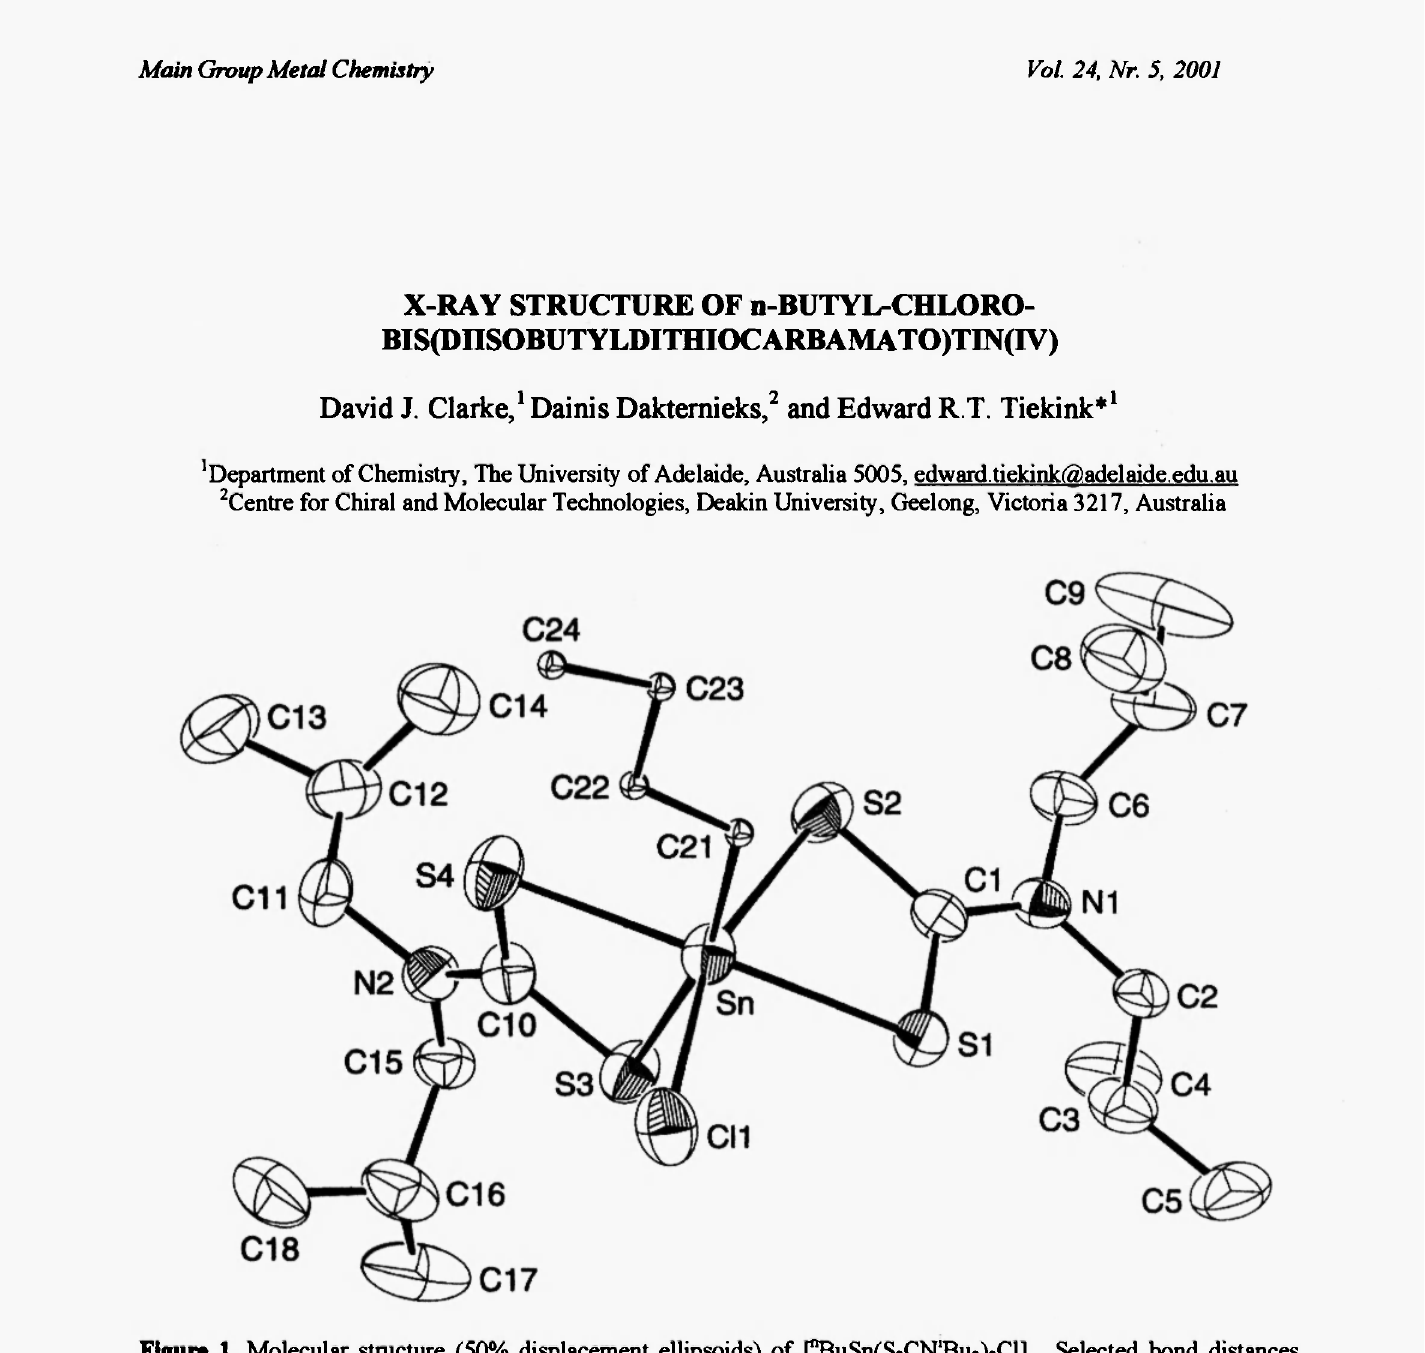
Figure 1. Molecular structure (50% displacement ellipsoids) of [°BuSn(S CN 1 Bu2)2Cl]. Selected bond distances 2 and angles: Sn-Cll 2.469(2), Sn-Sl 2.558(1), Sn-S2 2.628(2), Sn-S3 2.520(2), Sn-S4 2.618(2), Sn-C21 2.153(8), 51-Cl 1.730(5), S2-C1 1.716(5), S3-C10 1.725(5), S4-C10 1.729(5), Cl-Nl 1.326(6) and N2-C10 1.322(6) A; CI 1-Sn-Sl 91.24(5), Cll-Sn-S2 160.56(5), Cll-Sn-S3 91.12(6), Cll-Sn-S4 105.08(5), Cll-Sn-C21 92.2(2), Sl-Sn- S2 69.32(4), Sl-Sn-S3 87.52(5), Sl-Sn-S4 151.92(4), Sl-Sn-C2 104.3(2), S2-Sn-S3 87.45(6), S2-Sn-S4 92.62(5), 52-Sn-C21 93.3(2), S3-Sn-S4 69.80(5), S3-Sn-C21 167.7(2), S4-Sn-C21 97.9(2), Sn-Sl-Cl 87.4(2), Sn-S2-Cl 85.5(2), Sn-S3-C10 88.0(2), Sn-S4-C10 84.8(2), S1-C1-S2 117.8(3) and S3-C10-S4